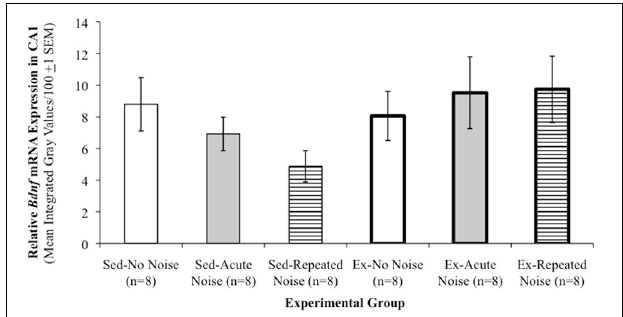
FIGURE 4 | Exercised rats appear less susceptible to stress-induced decreases in hippocampal Bdnf . Relative Bdnf mRNA expression levels in the CA1 sub-region of the hippocampus. Although group differences did not achieve statistical significance, a general pattern in Bdnf mRNA expression clearly emerged in this and the other three hippocampal sub-regions examined that is well-demonstrated by this particular figure, in that Ex rats did not appear to be susceptible to the same acute or repeated stress-induced decreases in hippocampal Bdnf mRNA expression that were exhibited in the Sed animals. Group means are mean integrated gray values/100 ( ± 1 s.e.m.), presented as arbitrary